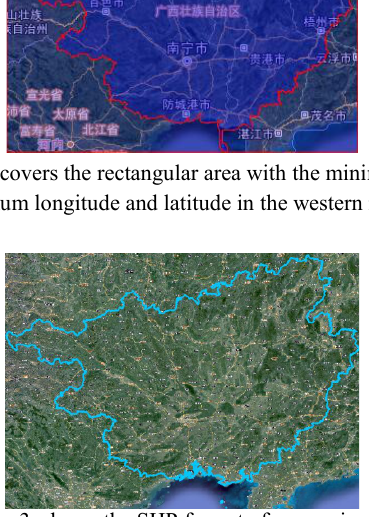
Figure 3. shows the SHP format of guangxi